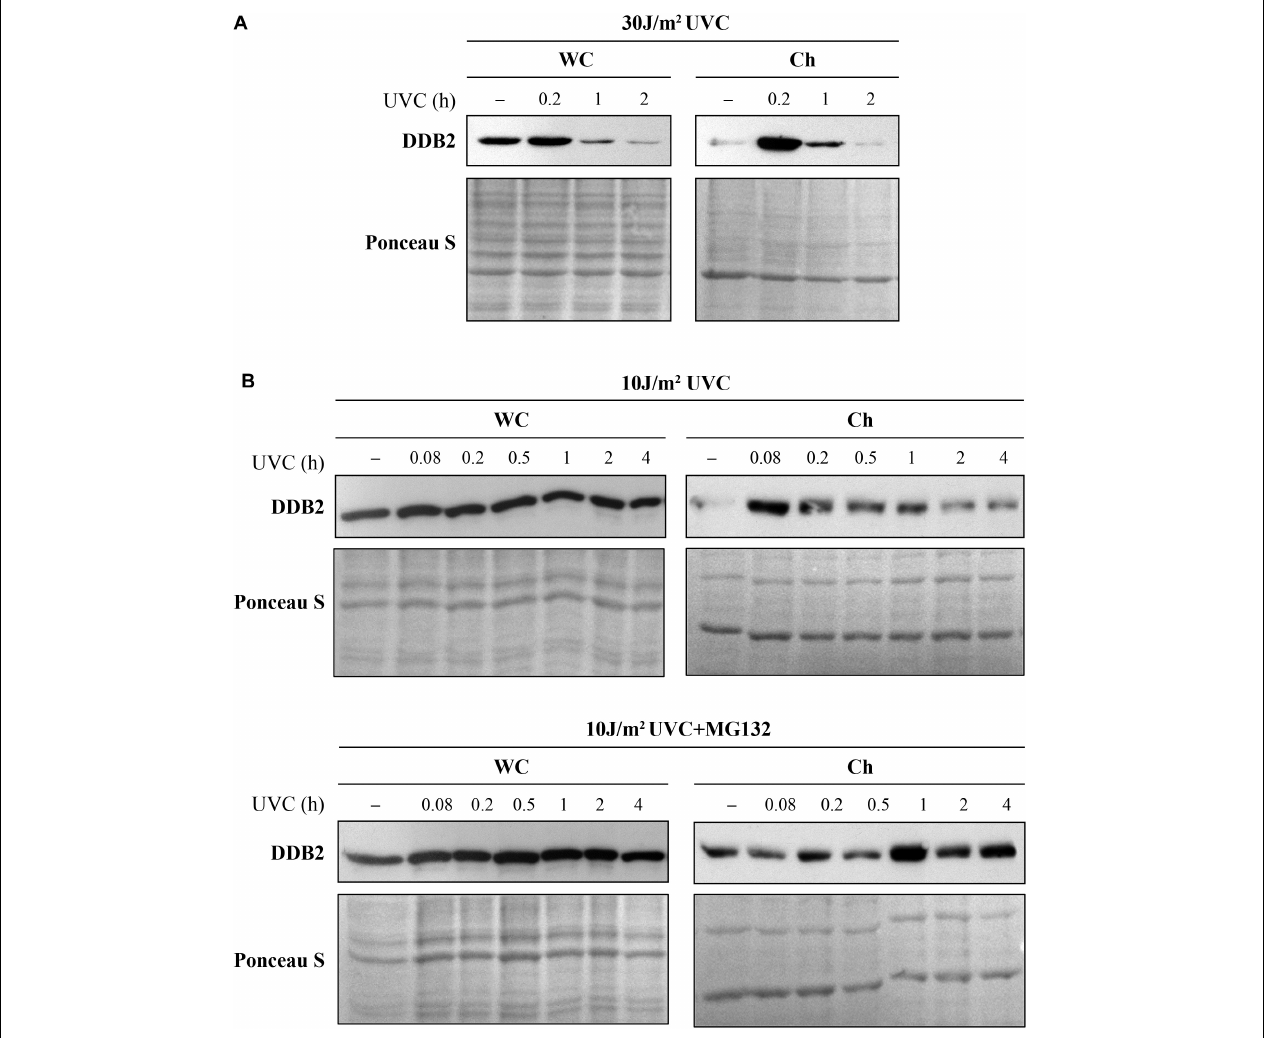
FIGURE 6 | Ultraviolet radiation irradiation induces the DDB2 ubiquitination and degradation. The GMU6 cells were globally irradiated with UVC at 30 (A) or 10 J/m 2 (B) , and fractionated at the indicated time. The whole cell extracts and chromatin-bound protein fractions were separated on SDS-PAGE and immunoblotted for DDB2. Where specified in panel (B) , 10 µ M of the proteasome inhibitor MG132 was added 1 h before irradiation with 10 J/m 2 UVC to show that the time-dependent depletion of DDB2 in Ch fraction is a result of proteasomal degradation of PTM-modified DDB2. Ponceau S staining was used as loading